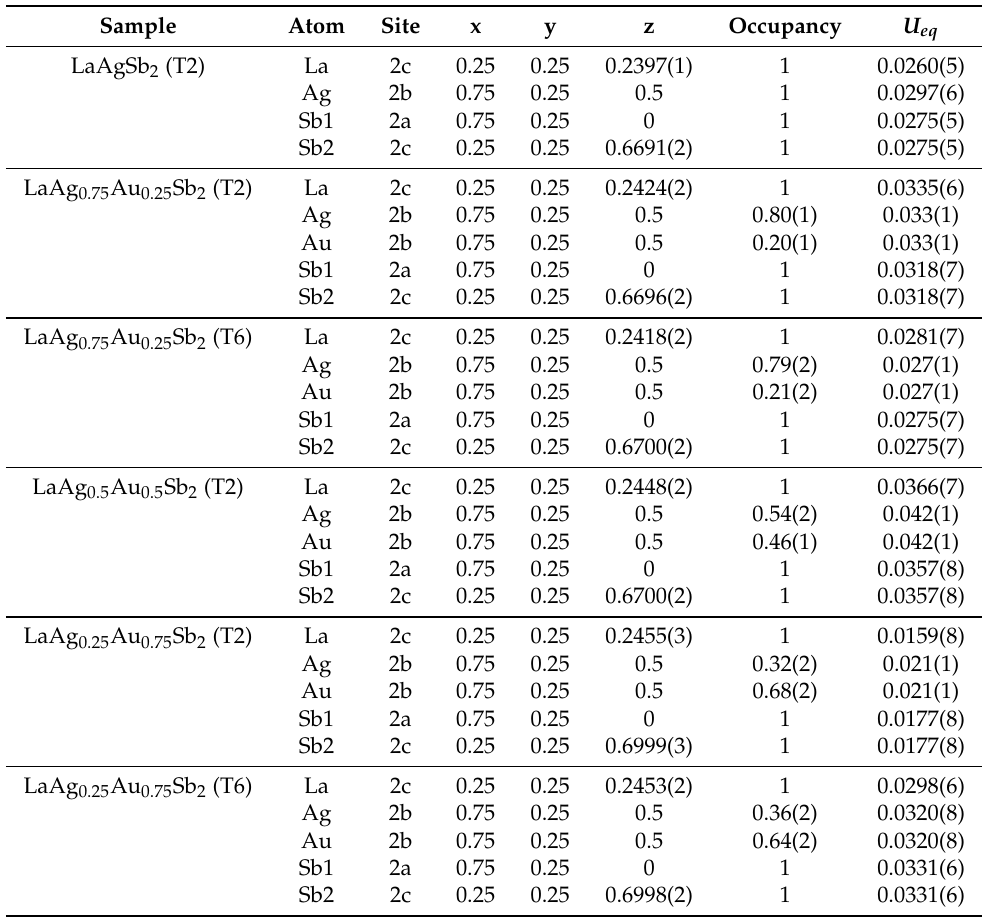
Table A2. Atomic coordinates, occupancy, and isotropic displacement parameters of LaAg 1 − x Au x Sb 2 samples (labels in parentheses indicate initial growth compositions, see Experimental details section for more details).